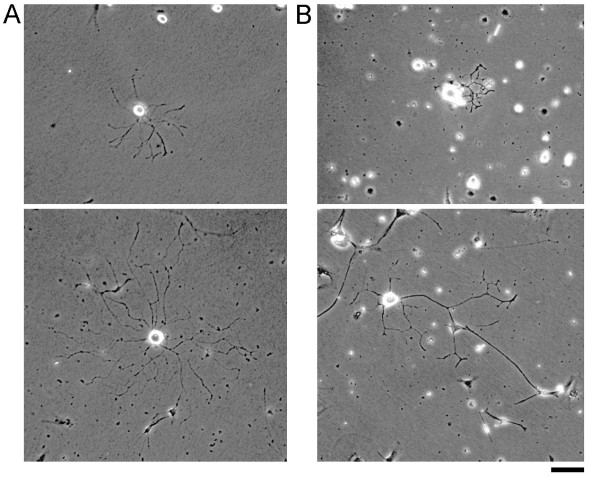
Examples of the outgrowth of neonatal (A.), and adult sensory neurons (B.). The top panels show growth after 1 day and the bottom panels show growth after 2 days in culture; bar = 45 µm.